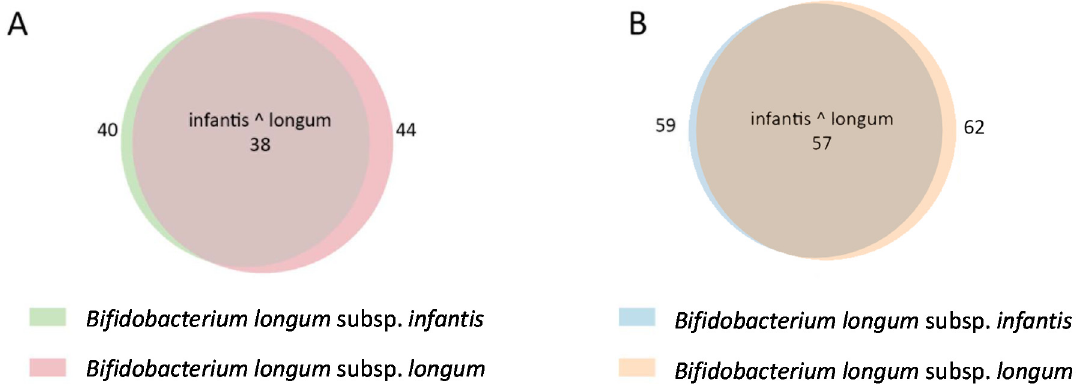
Figure 2. Venn diagram representing the distribution of glycoside hydrolases (GHs) in the Bifidobacterium longum reference strains ( A ) and the distribution of GH families ( B ). The numbers in the overlapping areas correspond to shared GHs ( A ) or GH families ( B ).